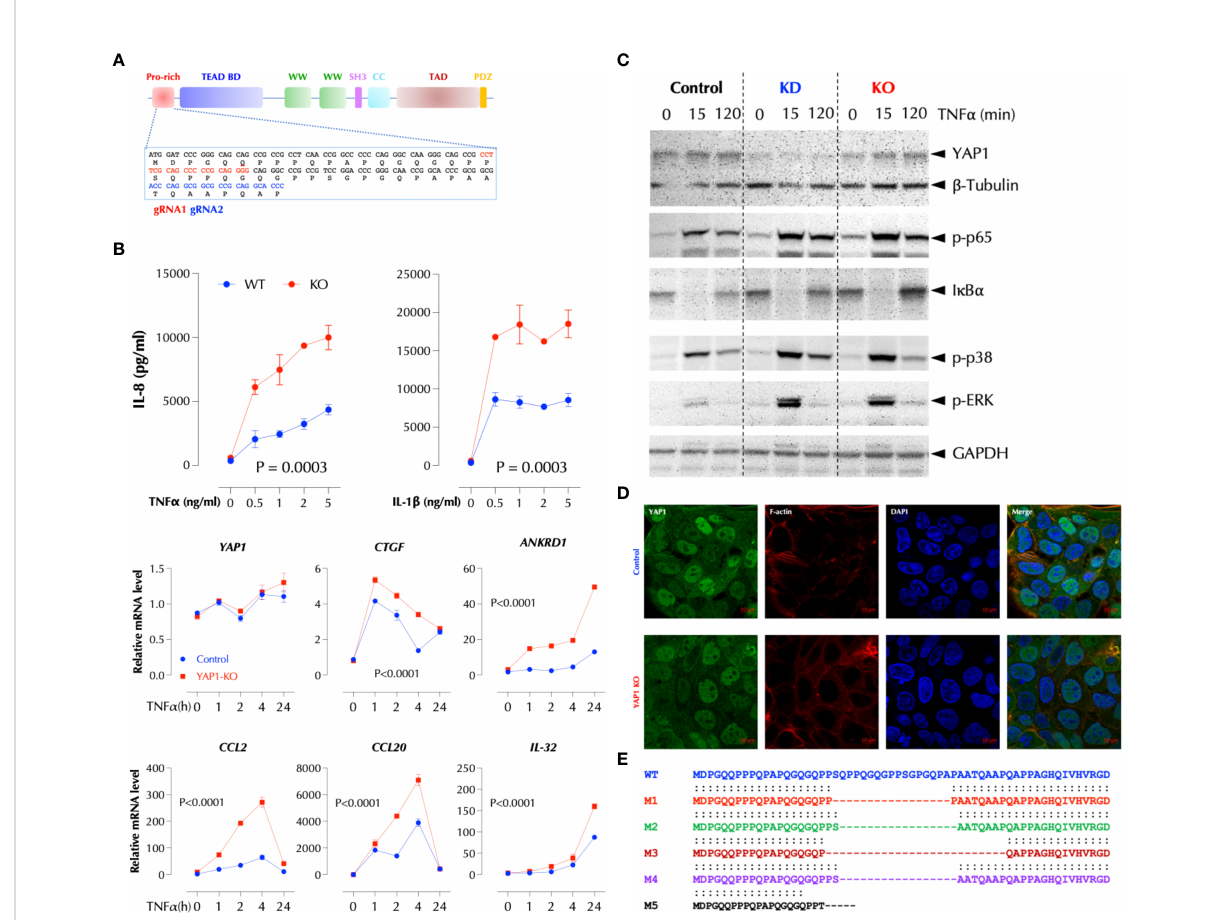
FIGURE 3 PRD is essential for the suppressive function of YAP1. (A) Crispr/Cas9-mediated KO strategy of YAP1. (B) YAP1 KO enhances TNF- and IL-1- induced IL-8 expression and TNF-induced genes in HCT-8. YAP1 KO cells were stimulated with the indicated amount of TNF a or IL-1 b overnight and IL-8 levels were measured by ELISA. TNF-induced gene expression was measured by qPCR after stimulation as indicated. The results are the representatives of two similar experiments. (C) YAP1 KD or KO enhances TNF a -induced activation of NF- k B and MAP